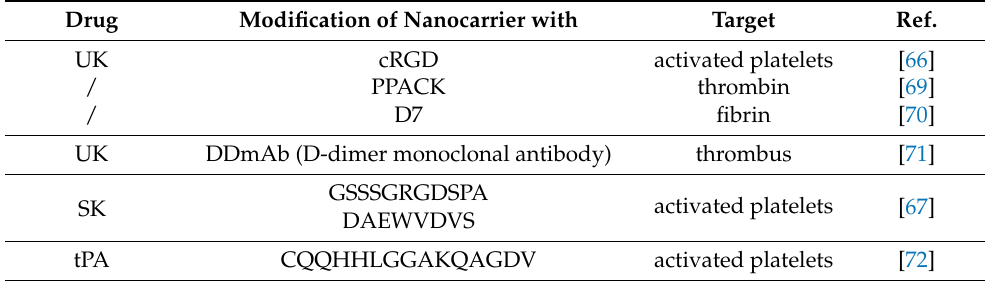
Table 2. Ligand modification of